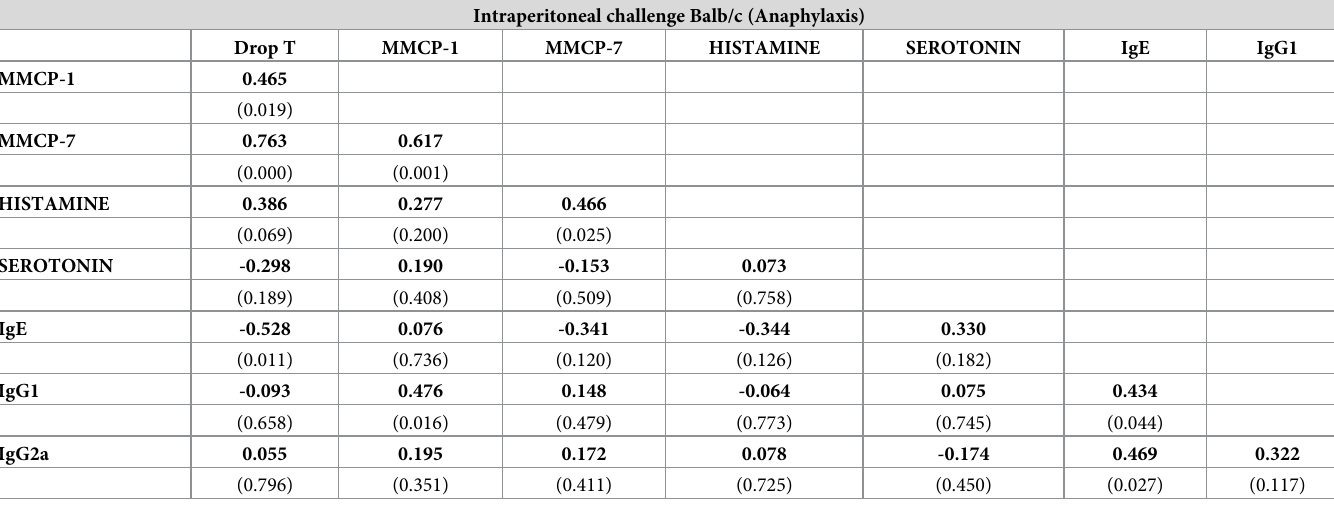
Table 7. Correlation between mast cell mediators measured in serum and anaphylaxis symptoms in Balb/c mice after intraperitoneal challenge.